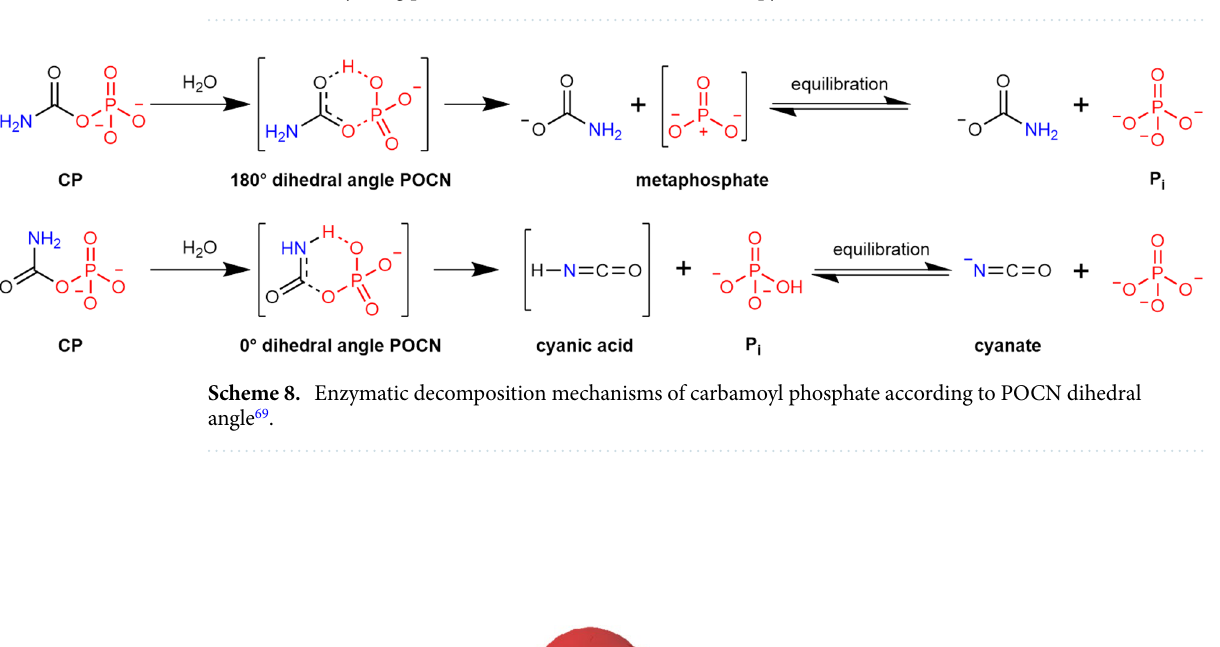
Figure 3. An energy diagram of CP degradation reactions in water at natural pH. CP itself could act as a carbamoylating agent (boxed in blue) or a phosphorylating agent (boxed in red). When it is isomerised to cyanate + P i , only the carbamoylating power is kept. Carbamate ( − O 2 C–NH 2 ) still contains the O–N–C moiety, but its carbamoylating power is weak due to its low free enthalpy.